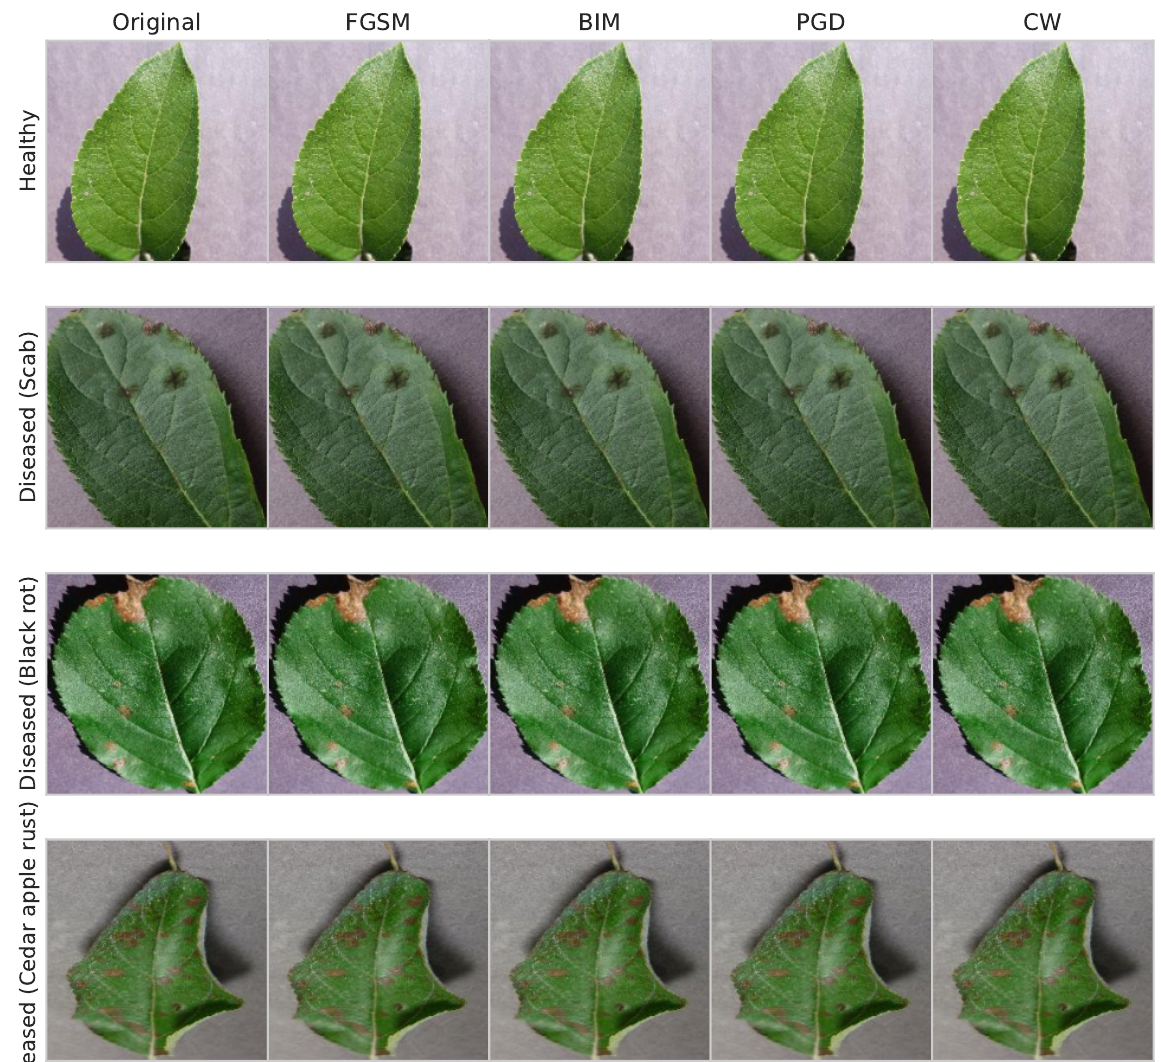
Figure 2. Examples of normal images and adversarial images generated by different attacks (VGG-16, 2-class, (cid:101) =